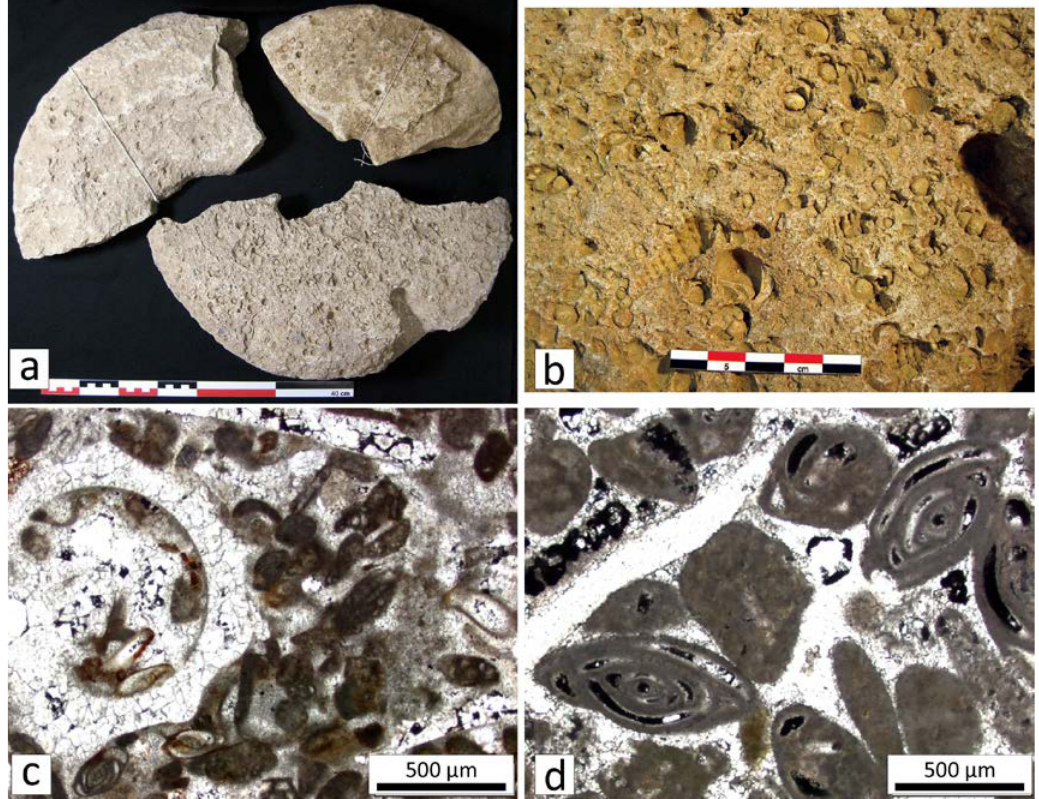
Figure 5. Example of a cerithids limestone rotary quern (diameter: 47 cm; thickness: 7.9 cm) catillus with an oval shaped eye (max. 13 cm) recovered in a pit (F.8014, sector H) among about 30 other quern fragments corresponding to at least five different individuals. The pit, dating from the Late Iron Age (La Tène finale 2b), was excavated in 2009 at Barenton-Bugny, Hauts-de-France, France. 5a and 5b: macrophotography, 5c and 5d: microphotography under planed polarised